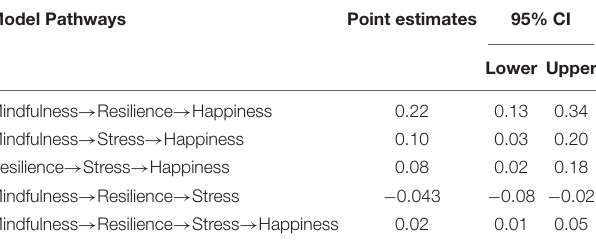
TABLE 2 | Bootstrapping indirect effects and 95% confidence intervals (CI) for the mediational model. Model Pathways Point estimates 95% CI